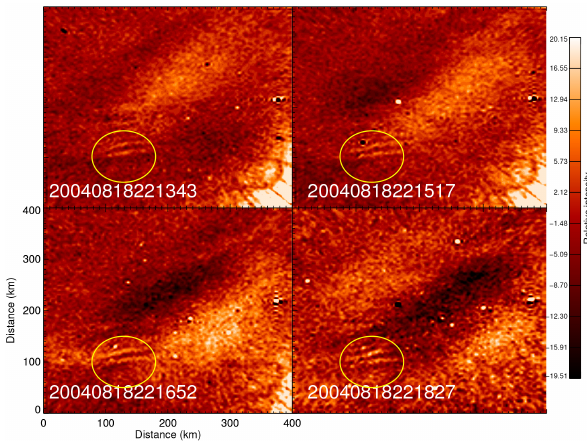
Figure 2. Processed Na image from 18 August 2004. The images were unwarped onto a 400 × 400km geographic grid (shown in the bottom left image) with the positive y axis corresponding to 0 ◦ lon- gitude. Yellow circles mark the location of the observed wave in each image. Time stamps are shown in the bottom left of each im- age, and are read as YYYYMMDDHHMMSS. The sequence of im- ages starts at the top left, and follows to the top right, bottom left, and finally bottom